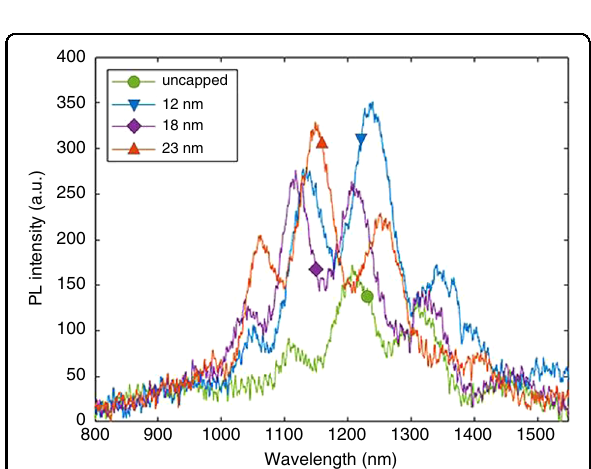
Fig. 8 PL from InN QDs capped with varying thicknesses of GaN. From Reilly et al., Phys. Status Solidi Basic Res. 257 , 1900508 (2020) © 2019 WILEY-VCH Verlag GmbH & Co. KGaA, Weinheim